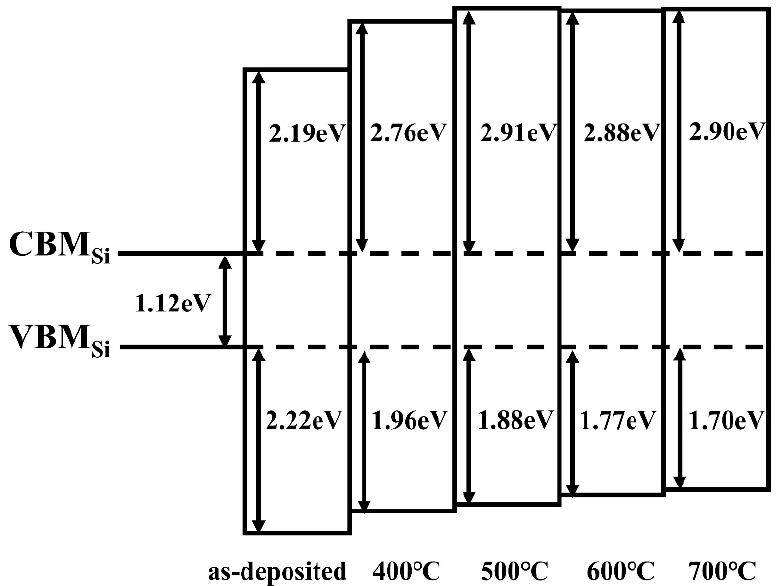
Figure 12. Schematic bands of lanthanum-doped HfO 2 thin films at different temperatures.